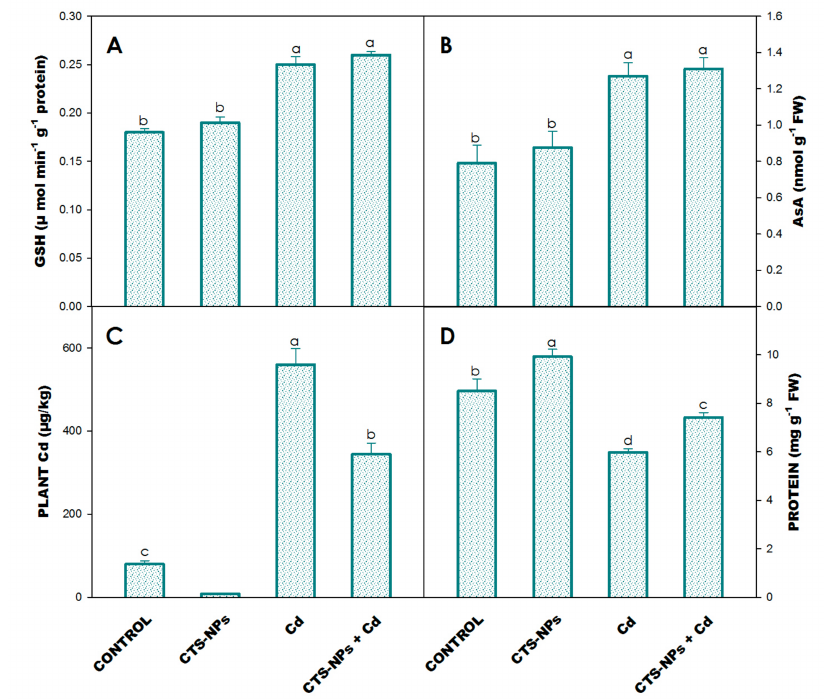
Figure 4. Effect of foliar application of chitosan nanoparticles (CTS-NPs) on the level of GSH ( A ), AsA ( B ), plant Cd ( C ) and protein ( D ) in cadmium (Cd) stress Solanum lycopersicum at 30 days after sowing. Values are the mean of five replicates with standard errors. Different bar letters show significant differences among treatments